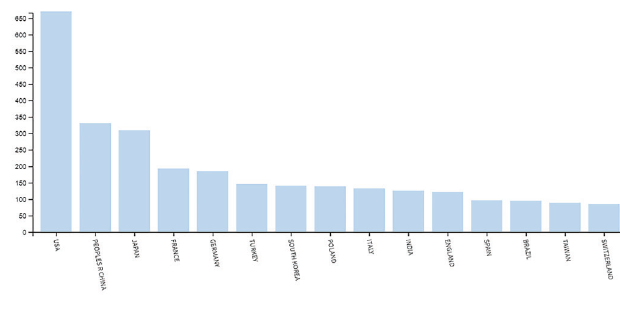
Figure 3 - Total publication density of world